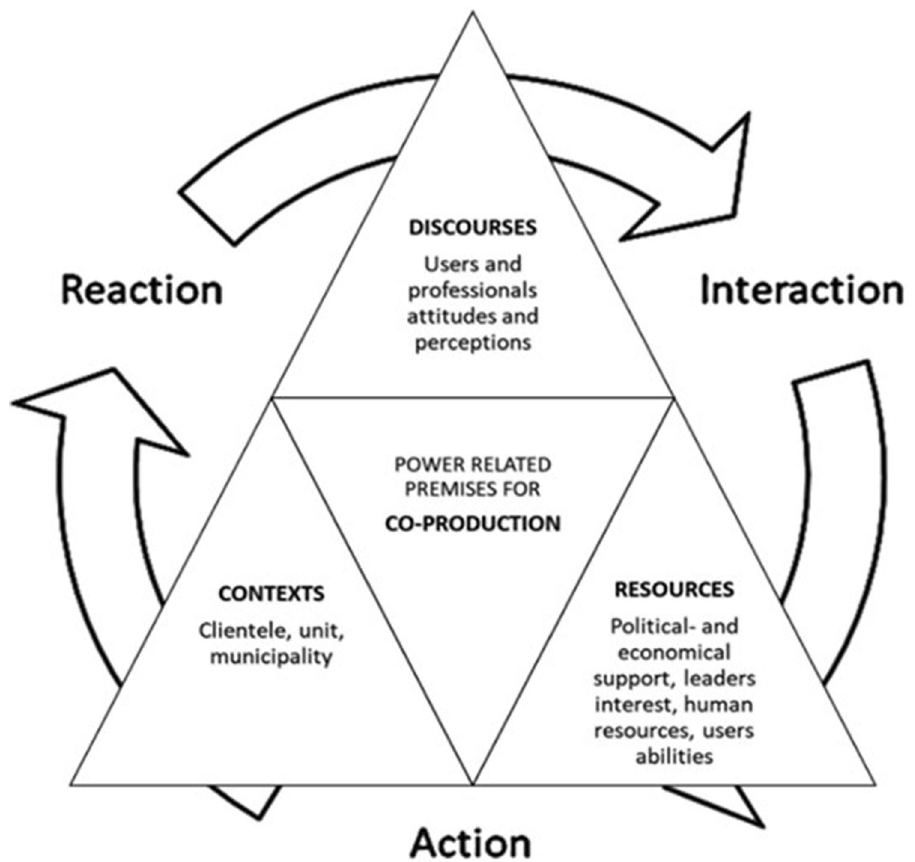
Fig. 2 The power triangle of co-production. Created by